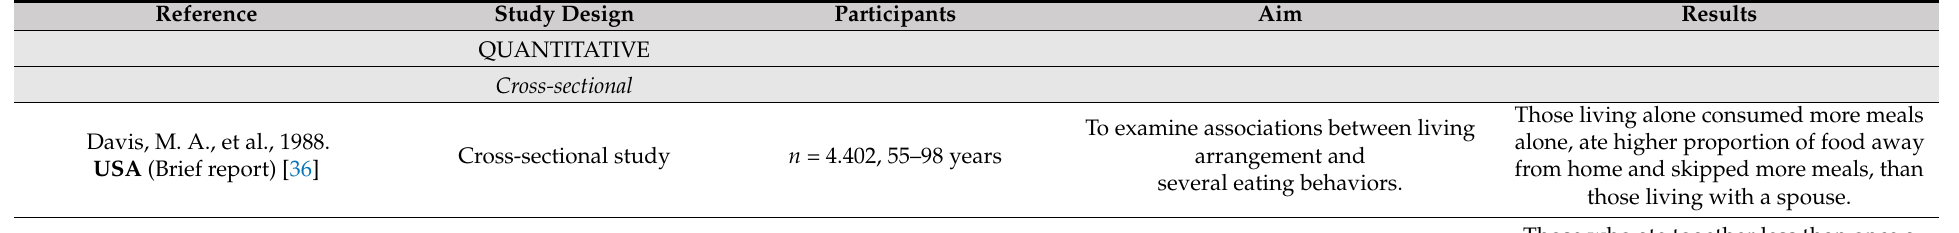
Table 1. Articles in the first category: central